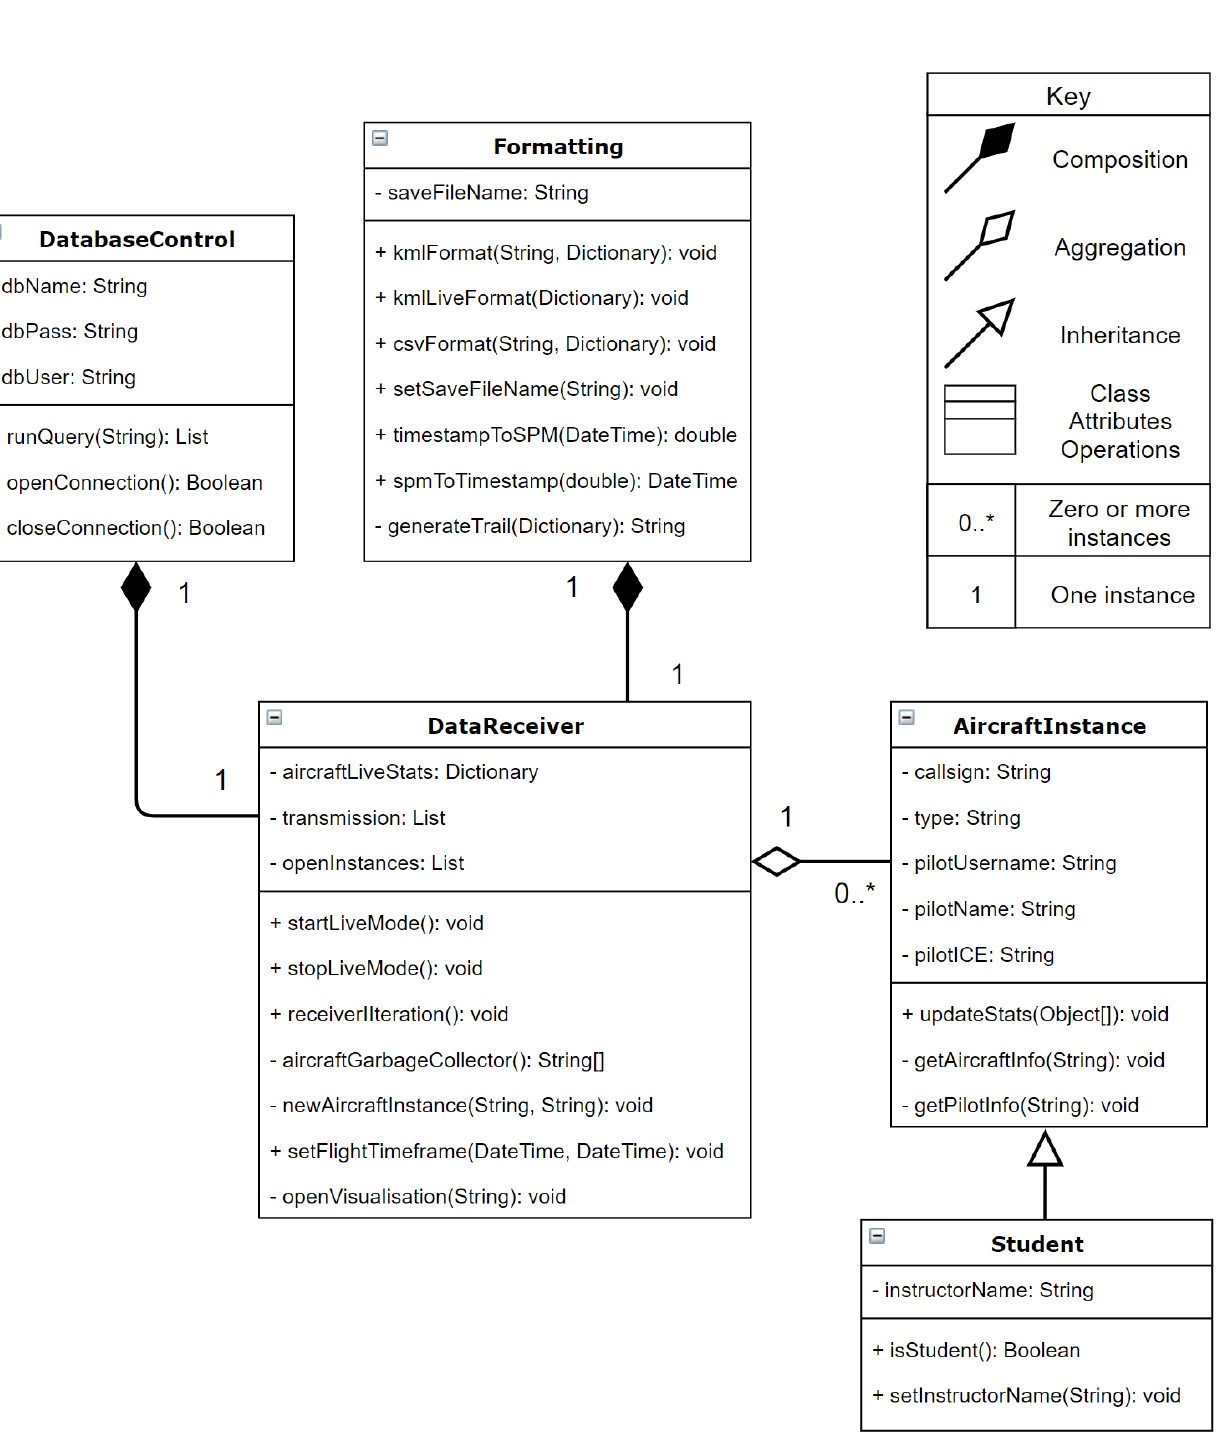
Figure 5. Class diagram of the desktop